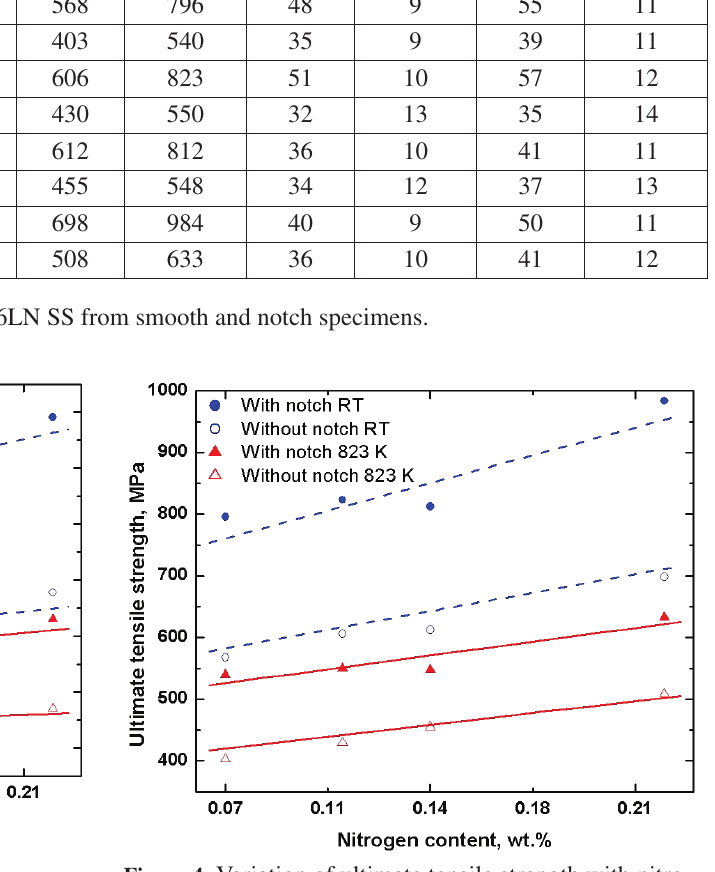
Figure 3. Variation of yield strength with nitrogen content of the steels at room temperature and 823 K.